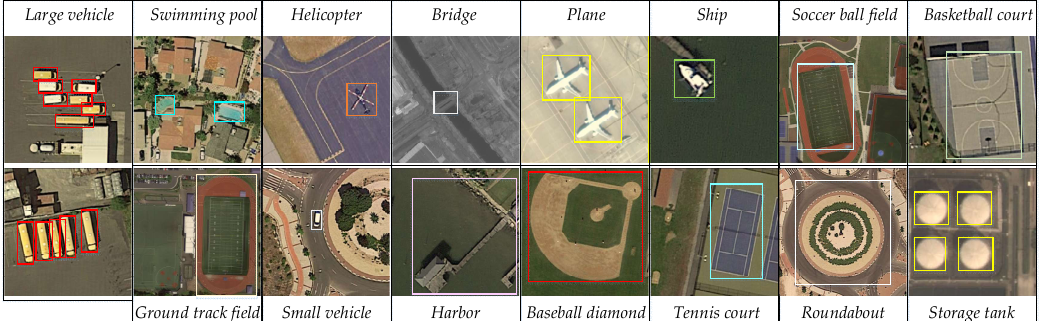
Figure 5. Samples of the 15-class geospatial object detection dataset.